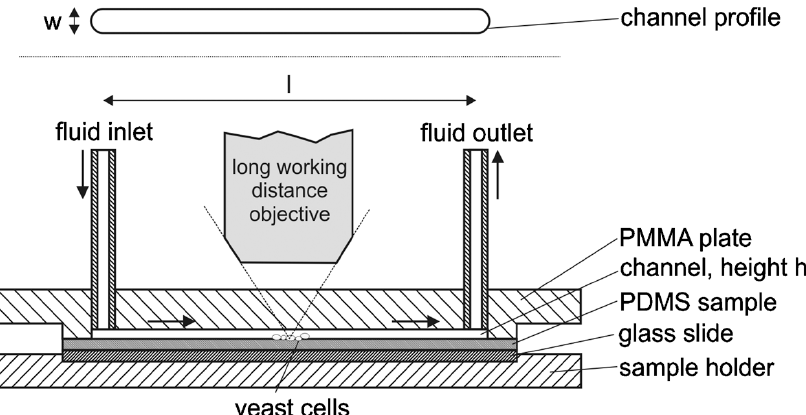
Figure 5. Scheme of the parallel flow channel used to study the strength of yeast cell attachment to different surfaces ( bottom : sectional view; top : channel profile). Reprinted with permission from [45]. © 2010 AIP Publishing